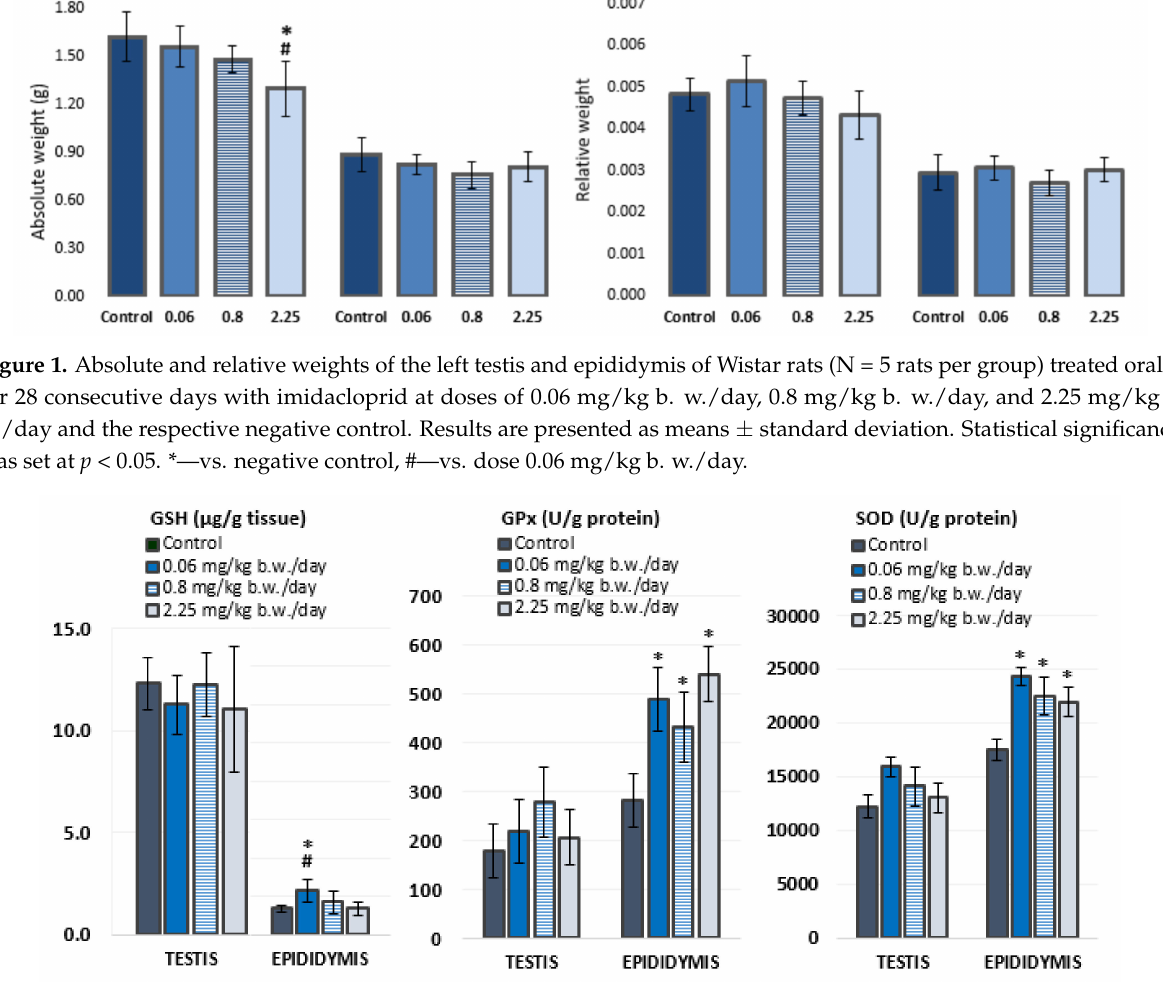
Figure 2. Parameters of antioxidant status measured in the testicular and epididymal tissue of Wistar rats (N = 5 rats per group) treated orally for 28 consecutive days with imidacloprid at doses of 0.06 mg/kg b. w./day, 0.8 mg/kg b. w./day, and 2.25 mg/kg b. w./day and in the negative control group. GSH—levels of glutathione; GPx—glutathione peroxidase activity; SOD—superoxide dismutase activity. Results are presented as means ± standard deviation. Statistical significance was set at p < 0.05 (*—vs. negative control, #—vs. dose 2.25 mg/kg b.